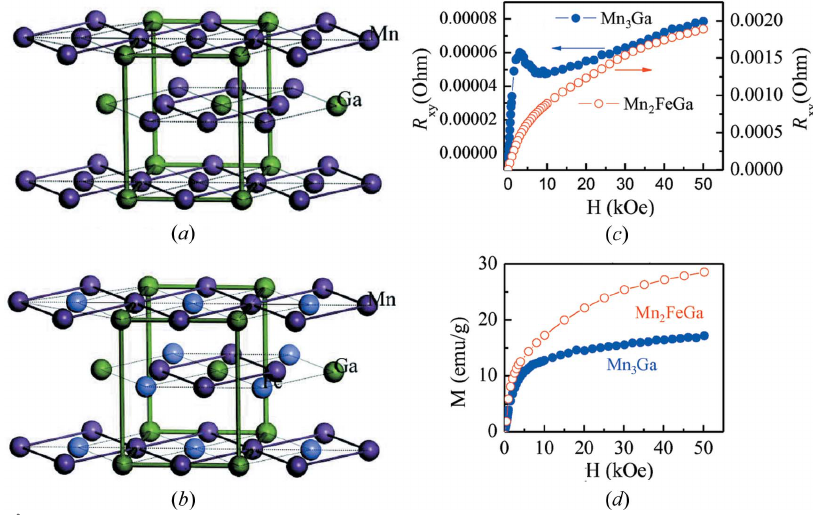
Figure 8 Schematic representation of hexagonal ( a ) Mn 3 Ga and ( b ) Mn 2 FeGa; ( c ) Hall resistance R xy as a function of the magnetic field measured at 5 K for hexagonal Mn 3 Ga and Mn 2 FeGa alloys; ( d ) initial magnetization curves at 5 K for hexagonal Mn 3 Ga and Mn 2 FeGa